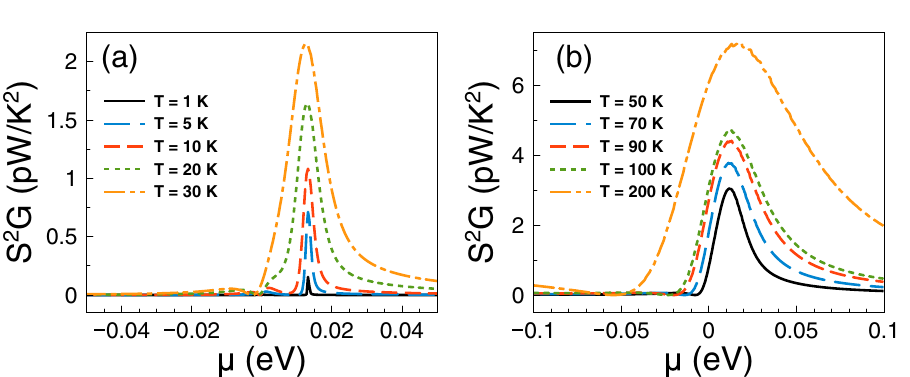
Figure 4. Power factor versus chemical potential for gapless bilayer graphene single barriers at different temperatures: ( a ) from 1 to 30 K and ( b ) from 50 to 200 K. The single barrier structural parameters are the same as in Fig. 2. In this case, the Fano resonances energy region dominates the power factor characteristics at practically all